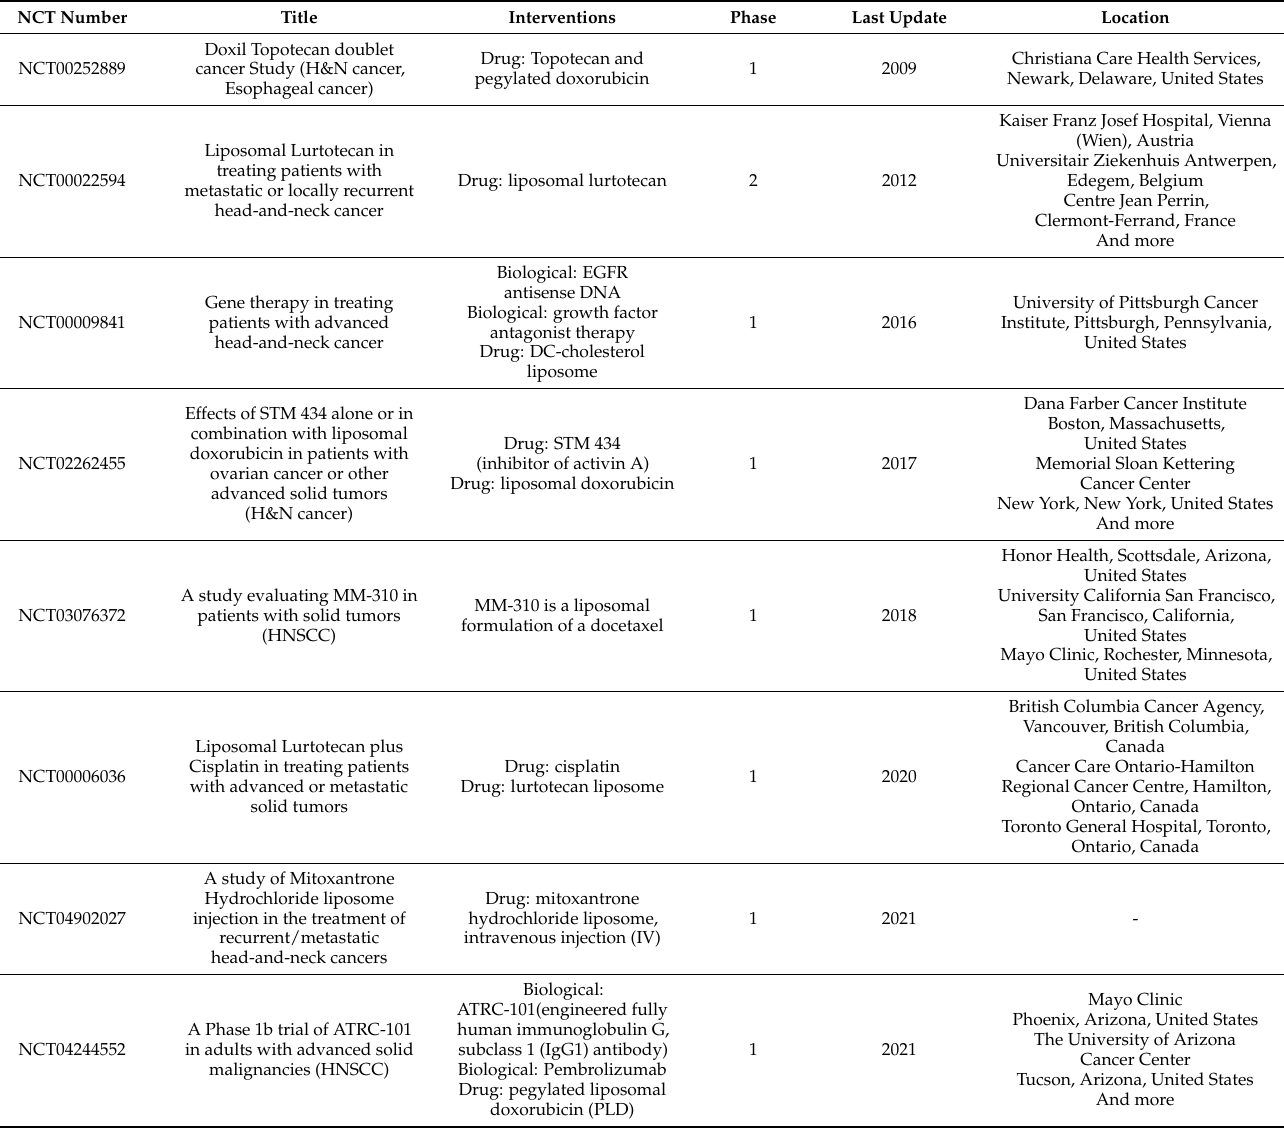
Table 4. Liposomes under evaluation in clinical trials (www.clinicaltrials.gov) for the treatment of H&N cancers (Keywords used for the search as head-and-neck cancer and